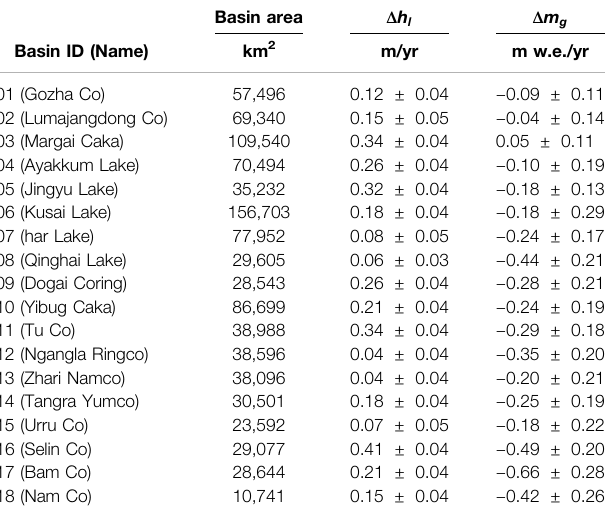
TABLE 2 | Lake level change ( Δ h l ) and speci fi c glacier mass balance ( Δ m g ) for each region. Basin